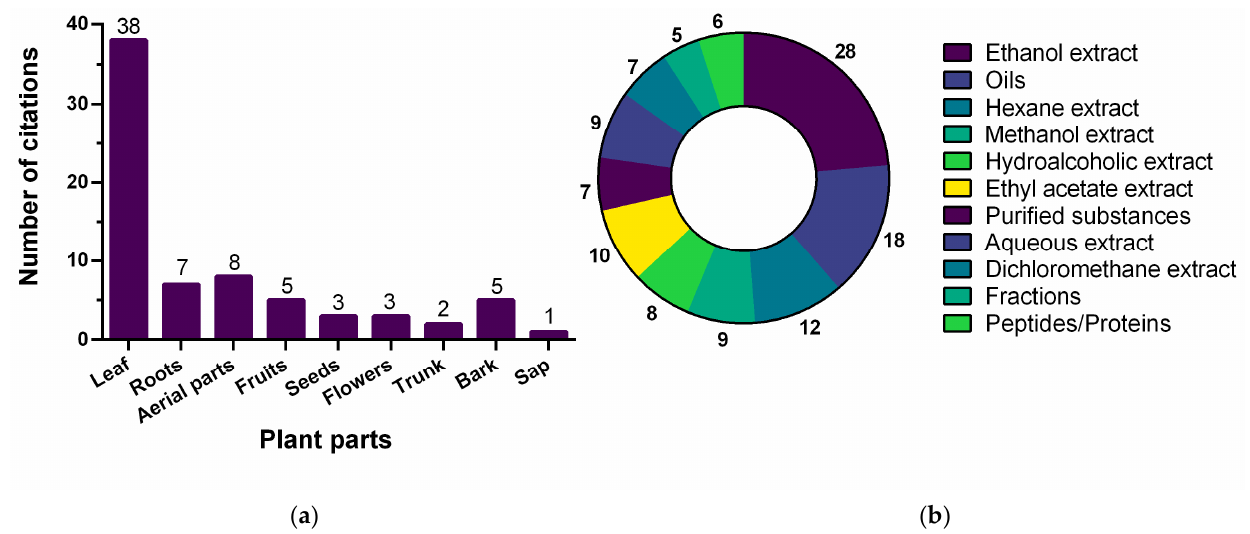
Figure 2. Total number of citations of the evaluated part of the plant ( a ) and the type of extract ( b